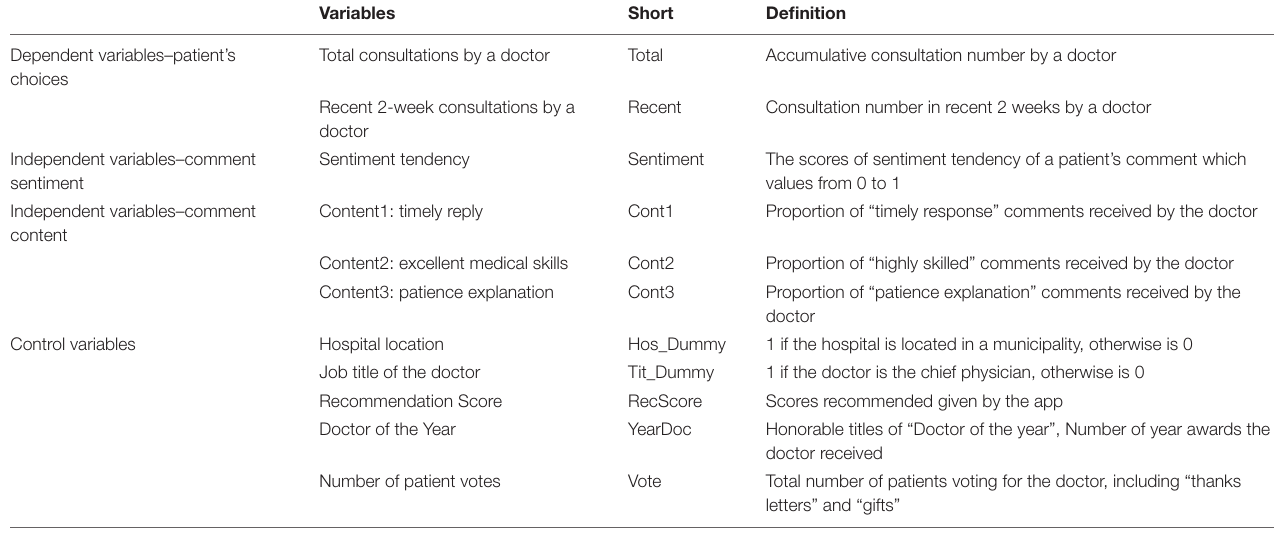
TABLE 4 | Summary of variables.